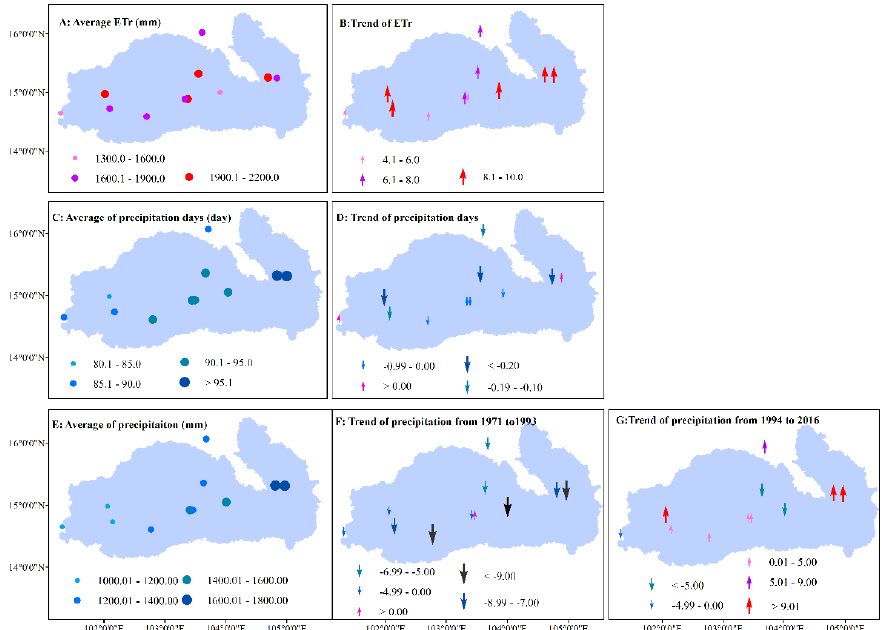
Figure 9. Spatial distribution of ETr, precipitation amount, and precipitation days during the period from 1971 to 2016. The solid circle and arrow indicate the amount and trend, respectively: ( A ) average ETr, ( B ) trend of ETr, ( C ) average precipitation days, ( D ) trend of precipitation days, ( E ) average precipitation amount, ( F ) trend of precipitation from 1971 to 1993, and ( G ) trend of precipitation from 1994 to 2016.